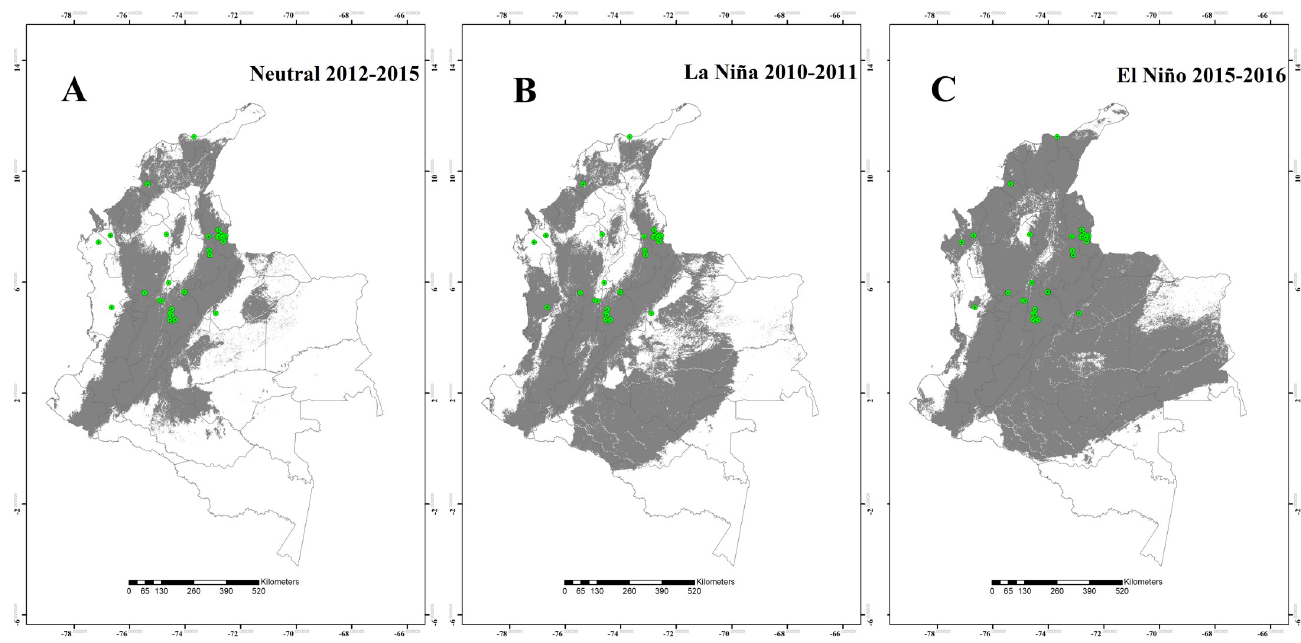
Fig 2. Potential distribution maps for Lutzomyia panamensis . (A) Neutral 2012–2015 episode. (B) La Ni ñ a 2010–2011 episode. (C) El Ni ñ o 2015–2016 episode. Models were calibrated across the hypothesized area of dispersion (M) and transferred across all Colombia. Green points are occurrences, gray areas are modeled suitable conditions, and white areas are unsuitable conditions. Points correspond to data in S1 Appendix, and maps were done using Maxent and ArcGIS software.